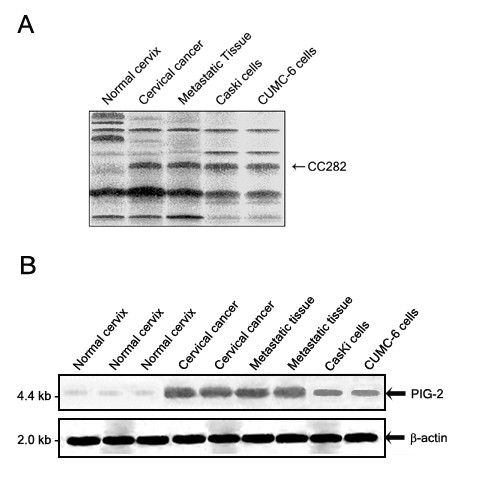
Identification and expression level of PIG-2. A) Comparison gene expression profiles by DDRT-PCR from total RNA isolated from normal cervical tissue, primary cervical cancer, cervical cancer tissue metastatic to lymph node and from CasKi and CUMC-6 cervical cancer cell lines. Differential display was carried out 5' arbitrary primer H-AP28 (5' -AAGCTTACGATGC-3') and 3' H-T11C (5' -AAGCTTTTTTTTTTTC-3'). The PCR products were resolved by electrophoresis. CC282 is the name of the partial PIG-2 gene product. The arrow identifies the location relative to other PCR products. (B) Total RNAs were isolated from normal cervical tissue, primary cervical cancer, cervical cancer tissue metastatic to lymph node and from CasKi andCUMC-6 cervical cancer cell lines. Blot was hybridized with the randomly primed [32P]-labeled PIG-2 partial cDNA probe (the CC282 fragment). Human β-actin cDNA was used as a control probe (lower panel).